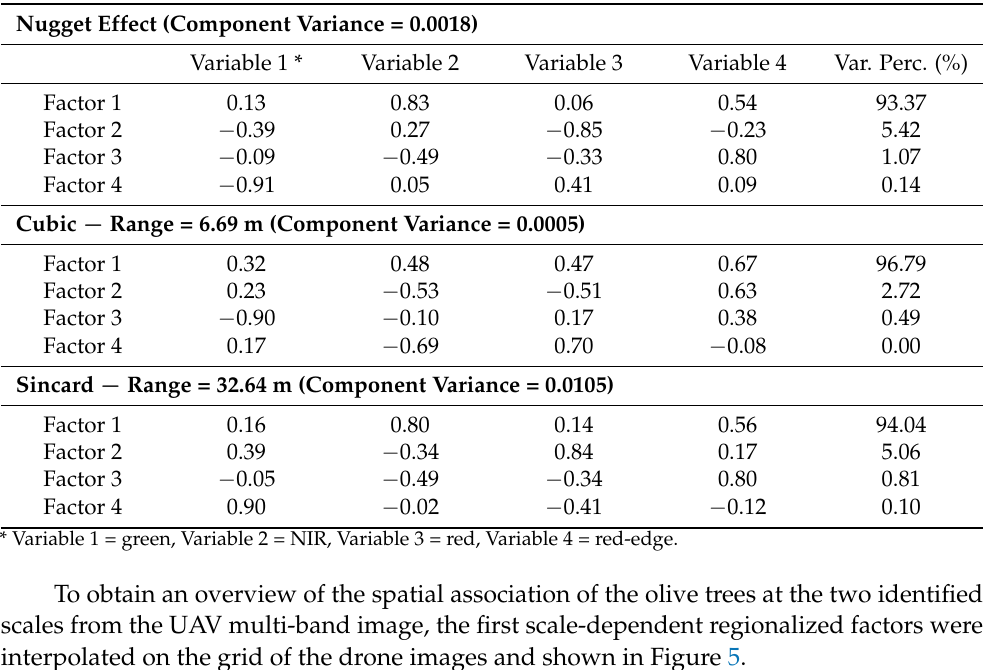
Table 2. Composition of regionalized factors at the different spatial scales. Nugget effect (component variance = 0.0018)